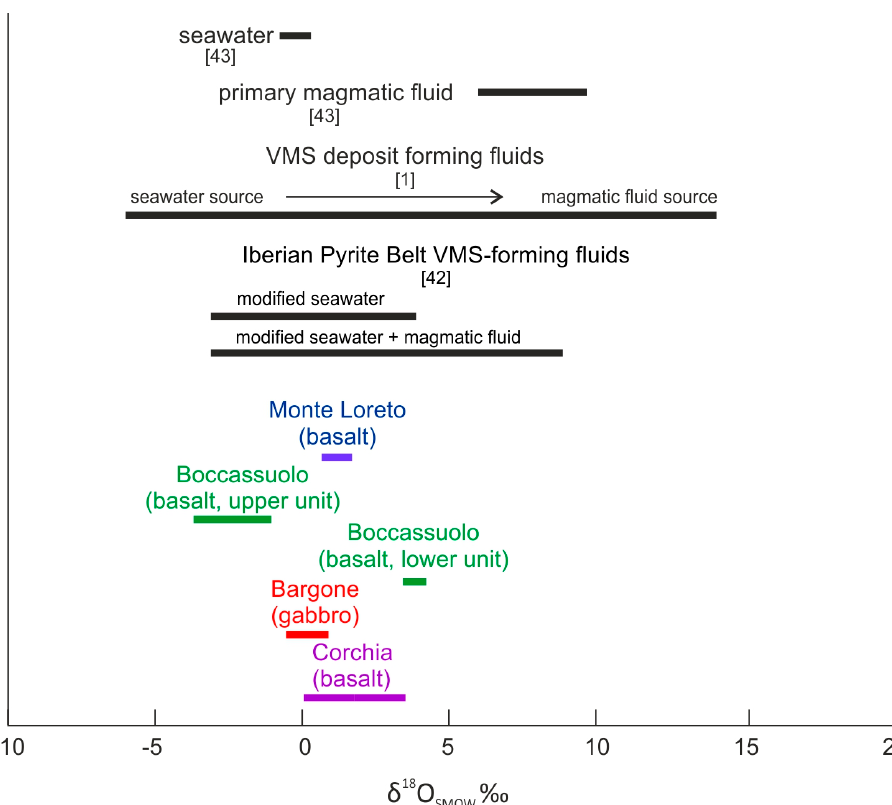
Figure 4. Stable isotopic composition of the fluid in equilibrium with late calcite from the studied locations. Reference values of [1,42,43] are shown on the top (in black) to assist interpretation. Stable and noble gas isotopic study of quartz and sulfide-hosted fluid inclusions com- plete the above results. The origin of the hydrothermal fluid can be effectively traced based on the fluid inclusions of hydrothermal minerals, such as quartz and sulfides, as they are less liable to diffusion [44]. This seems to be proven in our case, too, as there is no significant difference between our results obtained from quartz and sulfides. The obtained 40 Ar/ 36 Ar data are slightly different from the atmospheric values ( 40 Ar/ 36 Ar = 295 ± 0.5 [45]), show- ing crustal contribution [44]. Some exceptionally high values (up to 699 ± 29) can be explained by the potassium content of the commonly occurring sericite as an accidentally trapped mineral in the inclusions. The 4 He/ 20 Ne, as well as the 4 He/ 40 Ar* ratios, also support the deviation from atmospheric characteristics (Figure 5). This variance is most commonly of crustal origin, but in the case of the Boccassuolo (lower block), the magmatic (mantle) origin cannot be ruled out [44]. The ratio of He, Ne and Ar normalized to air also supports the modifying effect of fluid–rock interaction in the crust (Figure 6). How- ever, the low R/Ra values (up to 0.17) are the unambiguous result of this process, and the mantle-derived magmatic component (which would result in higher amounts of 3 He) can be clearly excluded for most of the samples [44]. This is supported by the δ D values (commonly between − 47 and − 39‰), which are within the typical VMS range [1] and show lower values than those that are characteristic of the typical field of magmatic fluids (between δ D − 50 and − 85‰ [43]). In the case of the Boccassuolo (lower block) samples, a small amount of mantle-derived (magmatic) fluid input can be assumed based on the combined evaluation of stable isotopic (see Figure 4 and δ D between − 42.99 and − 65.12‰) and noble gas isotopic values (Figure